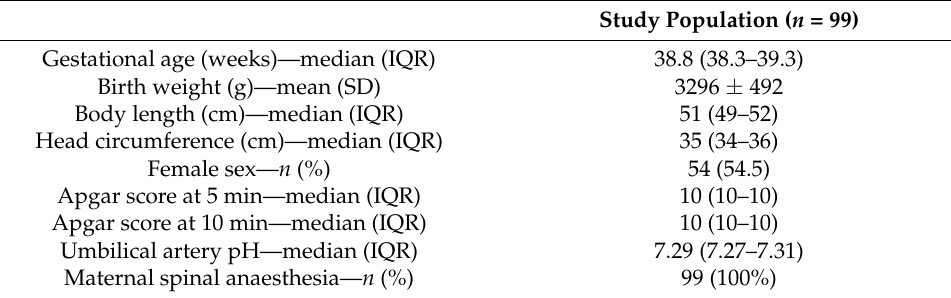
Table 1. Demographic and clinical characteristics of the study population.